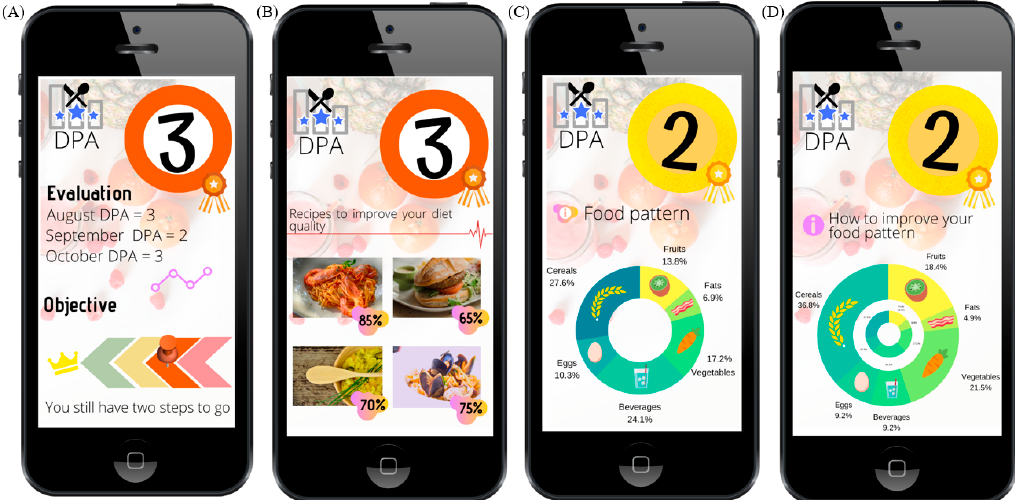
Figure 3. A sample of a mobile interface screens showing the DPA implementation as colored plates. ( A ) DPA score and the progress of the user; ( B ) tailored recipe suggestions; ( C ) the actual food groups; ( D ) some recommended improvements in order to provide personalized advice.